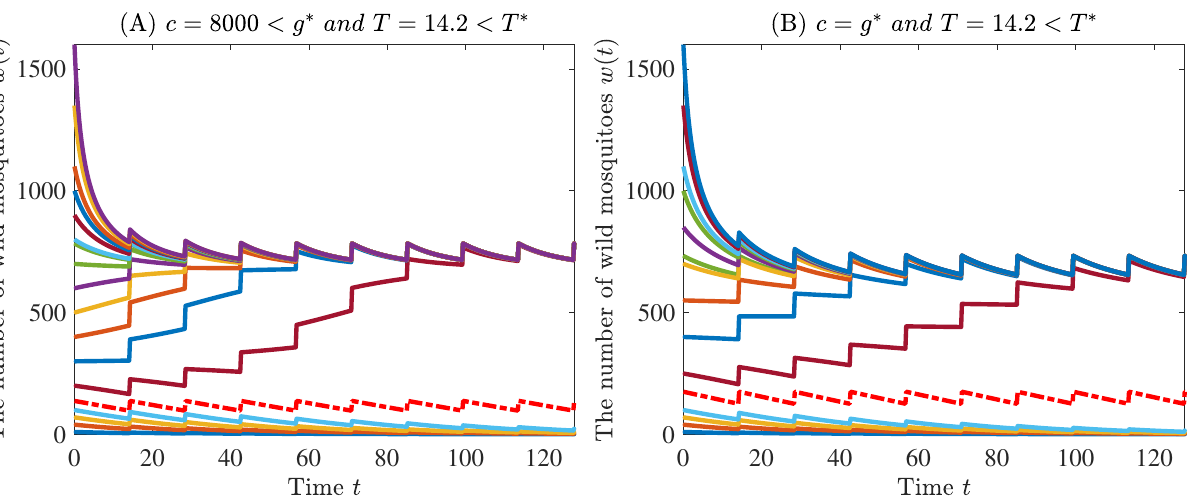
Figure 7. Let the parameters be set as in (51). Select T = 14.2. Choose c = 8000 < g ∗ in panel ( A ) and c = g ∗ in panel ( B ). Both panels show that the model (3) and (4) admits exactly two T -periodic